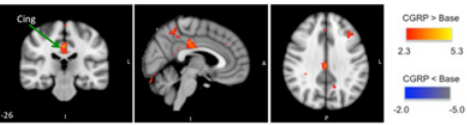
Fig 8. BOLD-signal after sumatriptan administration: Group BOLD-fMRI results for noxious heat simulations to the V1 area on the CGRP day; differences between neuronal activation at T 60 (after sumatriptan) and T 40 (during CGRP infusion/before sumatriptan). The activated regions-of-interest are shown in three projections. Sumatriptan injection resulted in positive activation of the cingulate cortex.